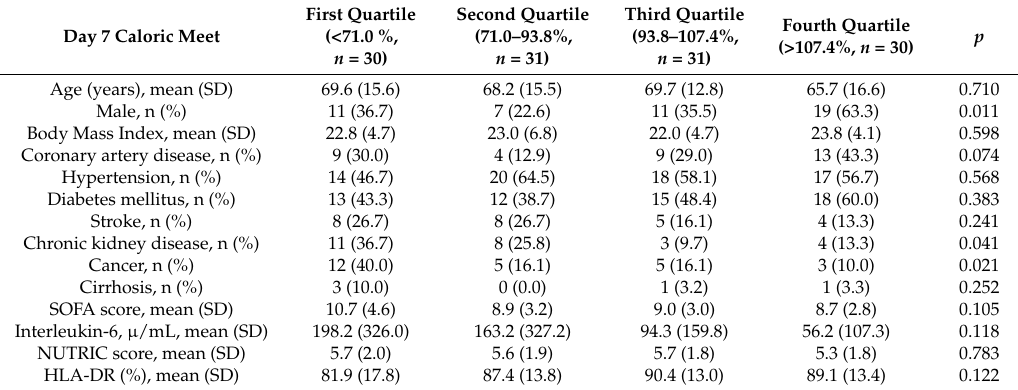
Table 2. Clinical characteristics and immune status between patients within different quartiles of caloric meet ( n =